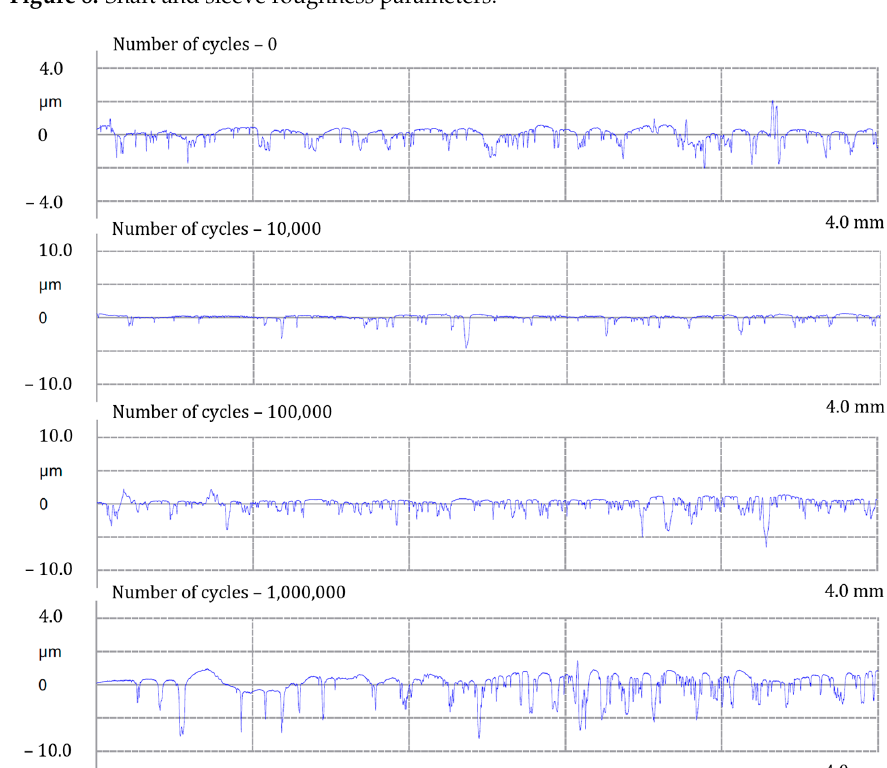
Figure 9. Roughness pro fi les recorded on the shaft surface.